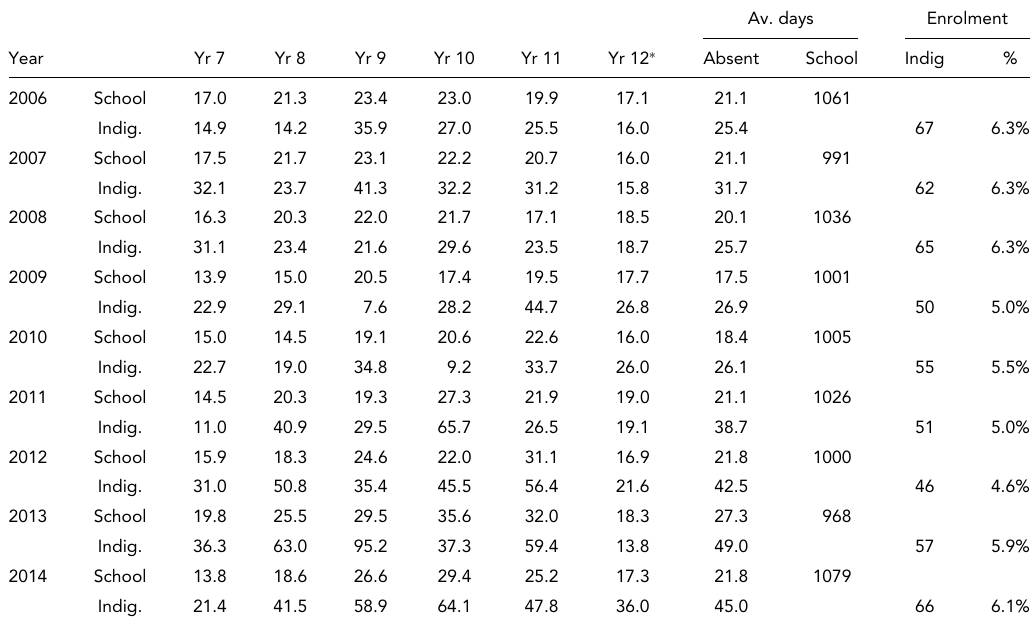
Days Absent — Indigenous Students — One Urban High School